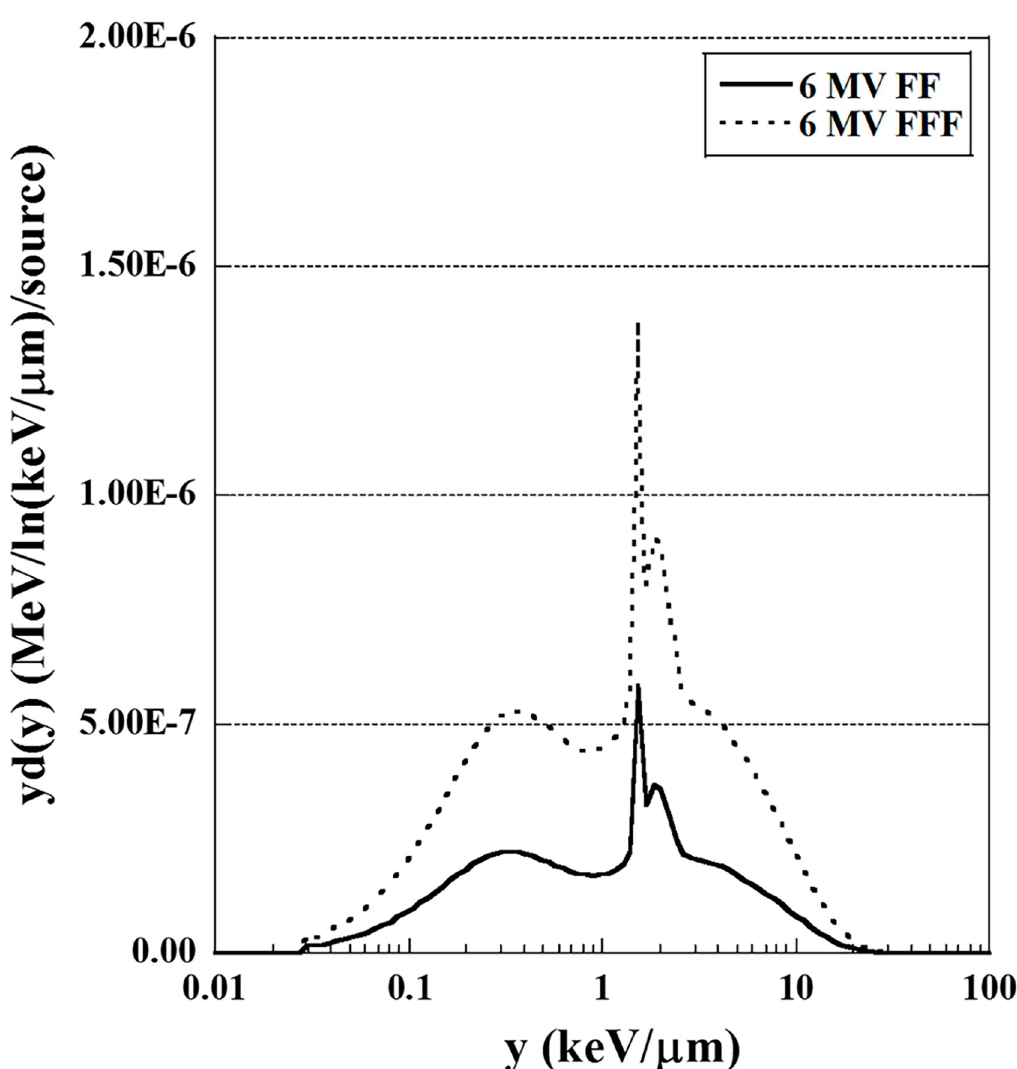
Fig 2. Microdosimetric energy distributions y water-equivalent phantom